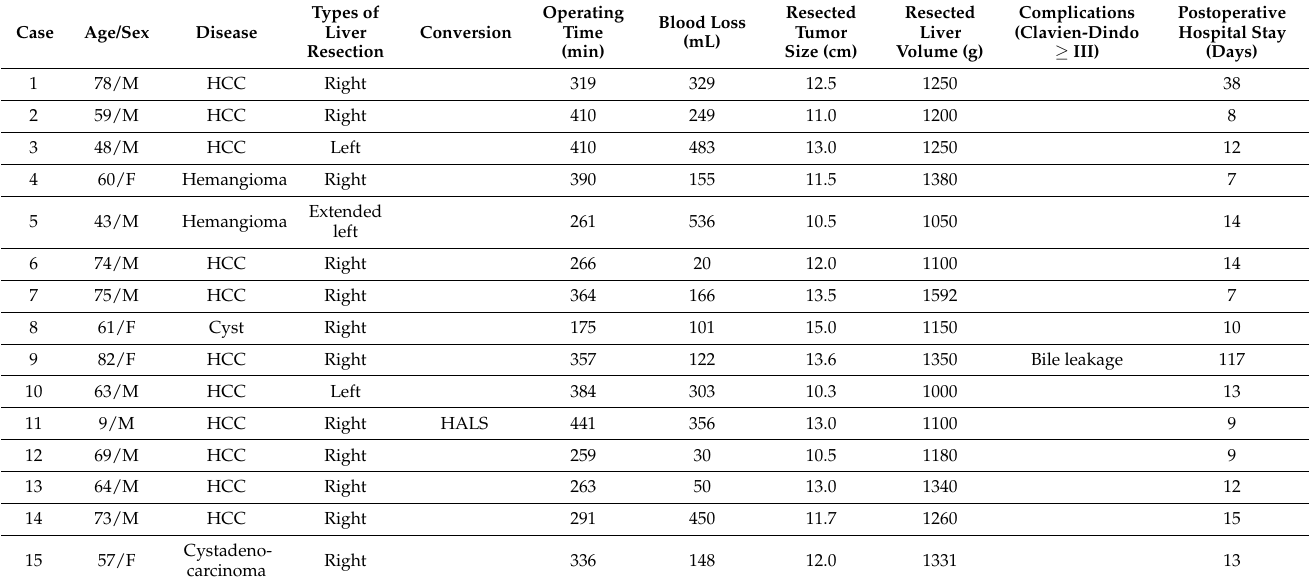
Table 1. Individual clinical data of 15 patients who underwent totally laparoscopic hemihepatectomy with an anterior approach for giant liver tumors larger than 10 cm in diameter.